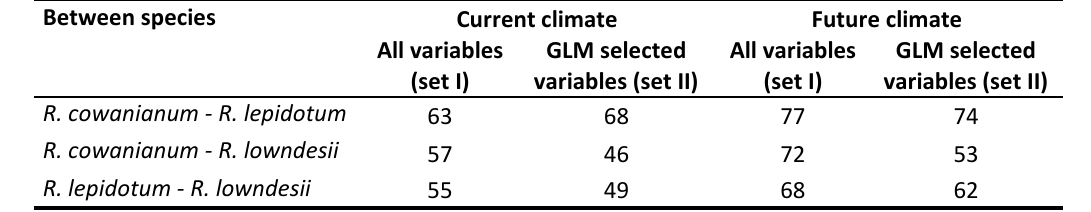
Table 2 . Results of the potential distribution overlap analysis between three Rhododendron species in current and the future climatic conditions. Values correspond to percentage of